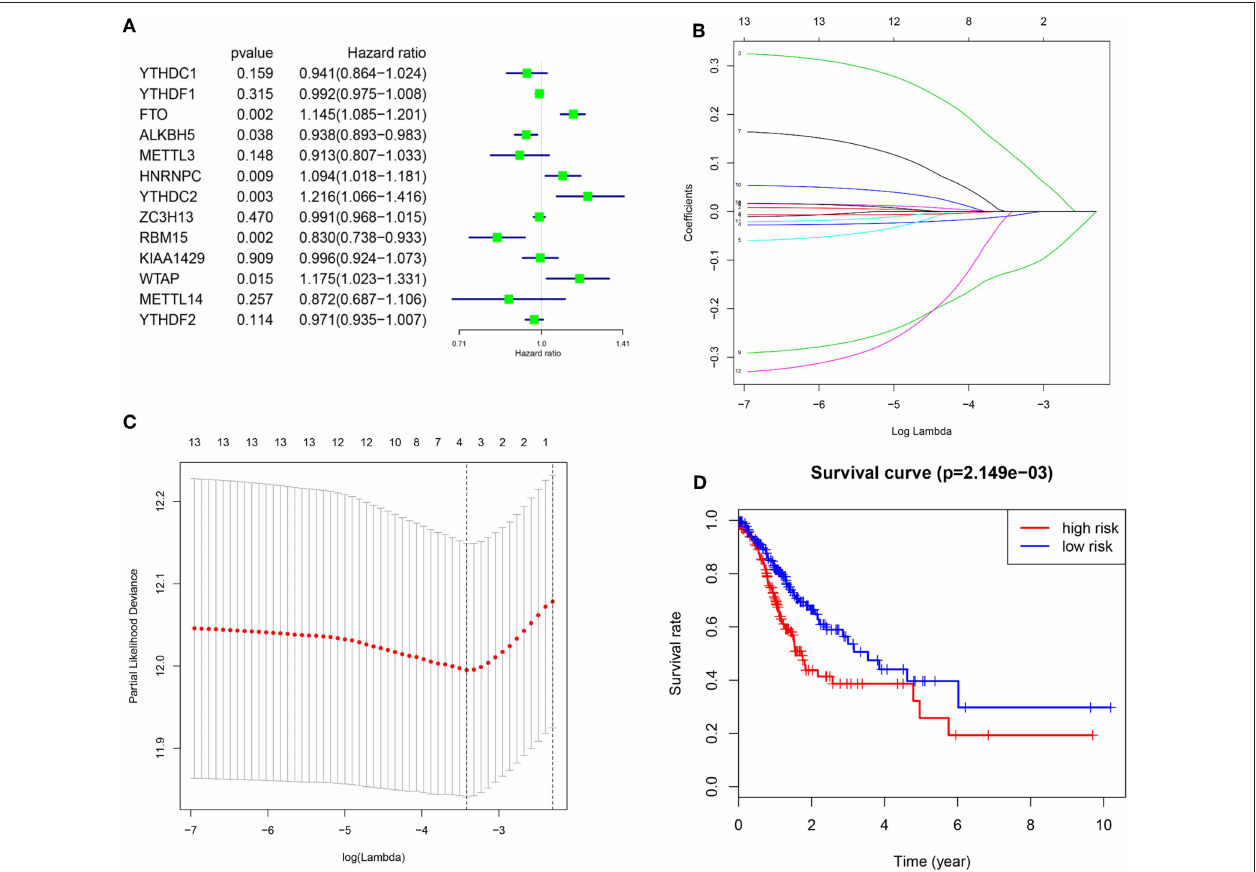
FIGURE 4 | Risk signature with three m 6 A RNA methylation regulators. (A) The process of building the signature containing 13 m 6 A RNA methylation regulators. The hazard ratios (HR), 95% confidence intervals (CI) calculated by univariate Cox regression. (B,C) The coefficients calculated by multivariate Cox regression using LASSO are shown. (D) Kaplan–Meier overall survival (OS) curves for patients in the TCGA datasets assigned to high and low risk groups based on the risk